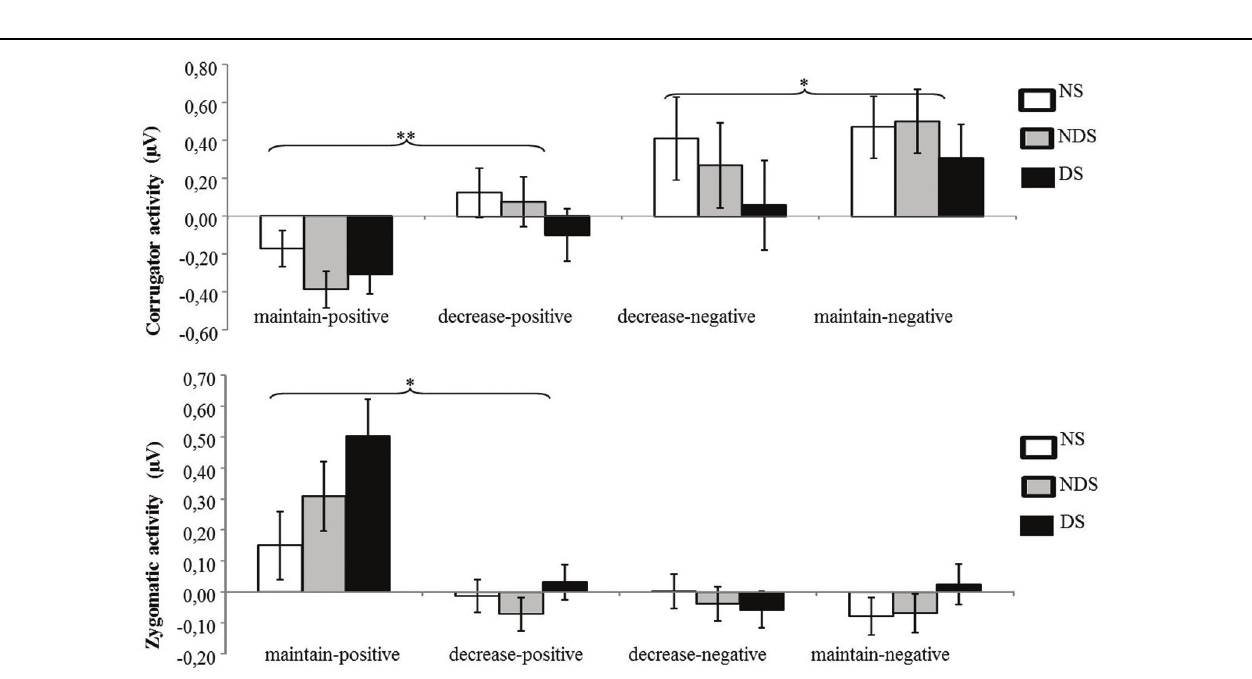
FIGURE 2 | Mean changes in facial electromyography (EMG) activity as a function of reappraisal among NS, NDS, and DS. Depicted are difference scores (specific emotion condition minus baseline condition; see Materials and Methods) in corrugator activity (top) and zygomaticus activity (bottom) . The more positive difference scores in corrugator activity (top) represent more negative facial expressions; in contrast, the more positive difference scores in zygomaticus activity (bottom) represent more positive facial expressions under specific emotion condition comparing to baseline condition. Error bars represent standard error of the mean (SEM). ∗ p < 0.05, ∗∗ p <